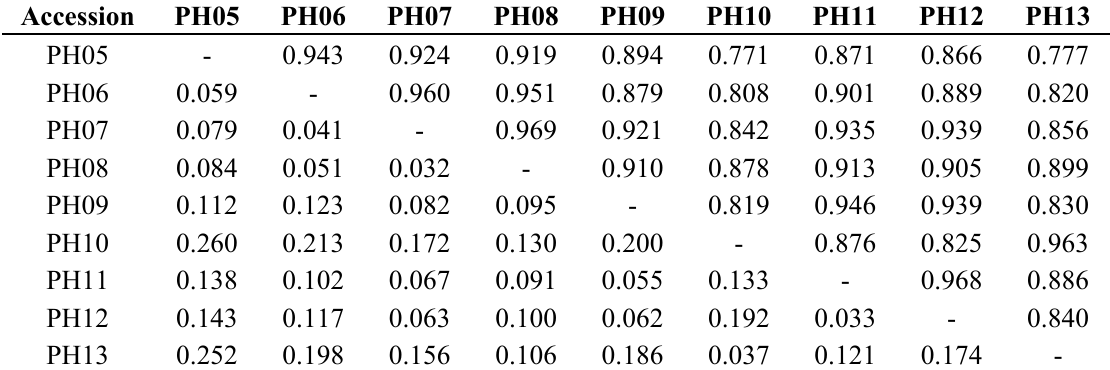
Table 4. Pairwise comparison of Nei’s genetic identity (above diagonal) and genetic distance (below diagonal) between common bean “Badda” accessions.